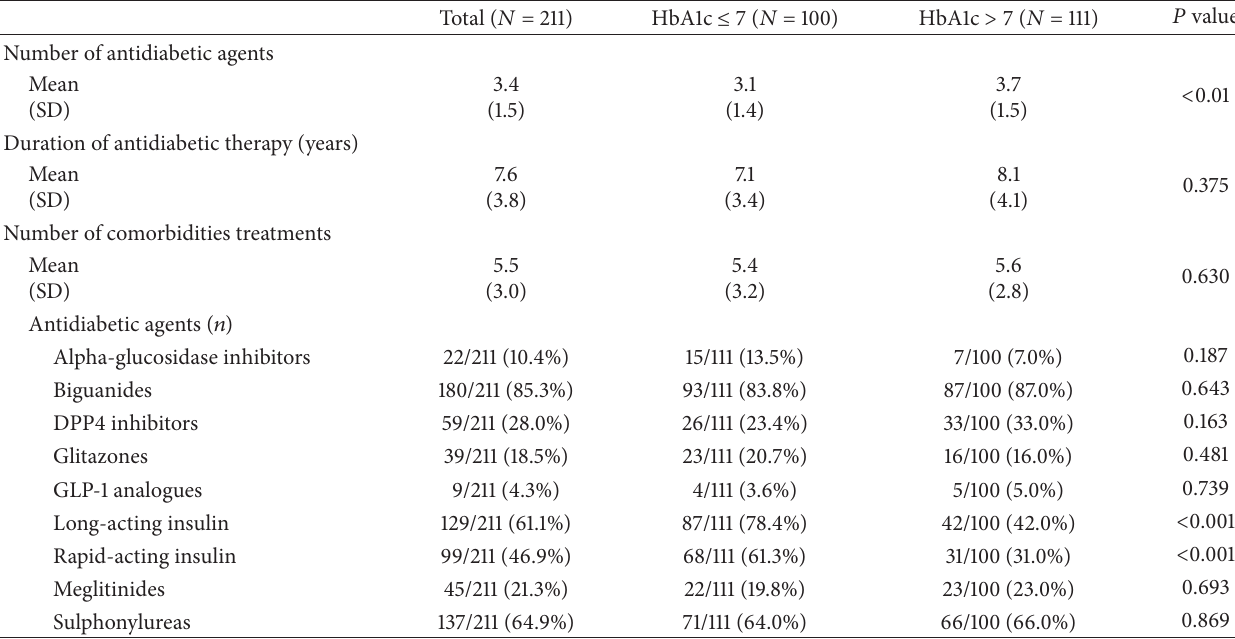
Table 3: Pharmaceutical treatment: antidiabetic and comorbidities therapies.